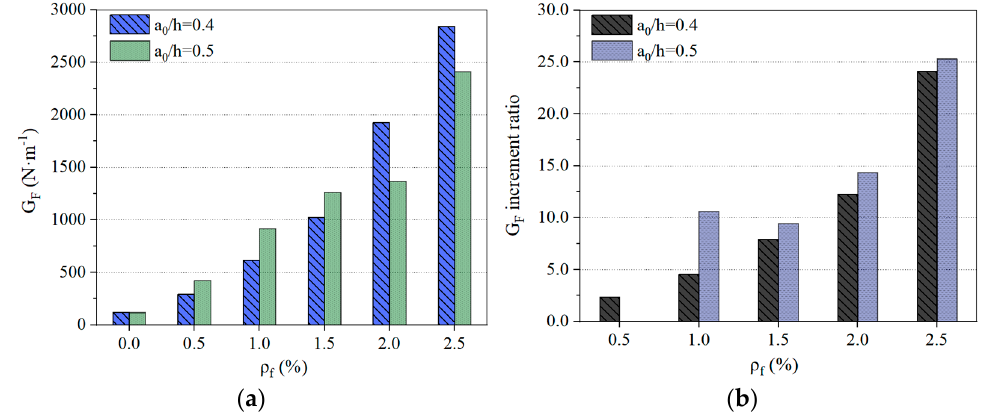
Figure 12. Influence of ρ f on the G F ( a ) and G F increment ratio ( b ) of SFHSC.